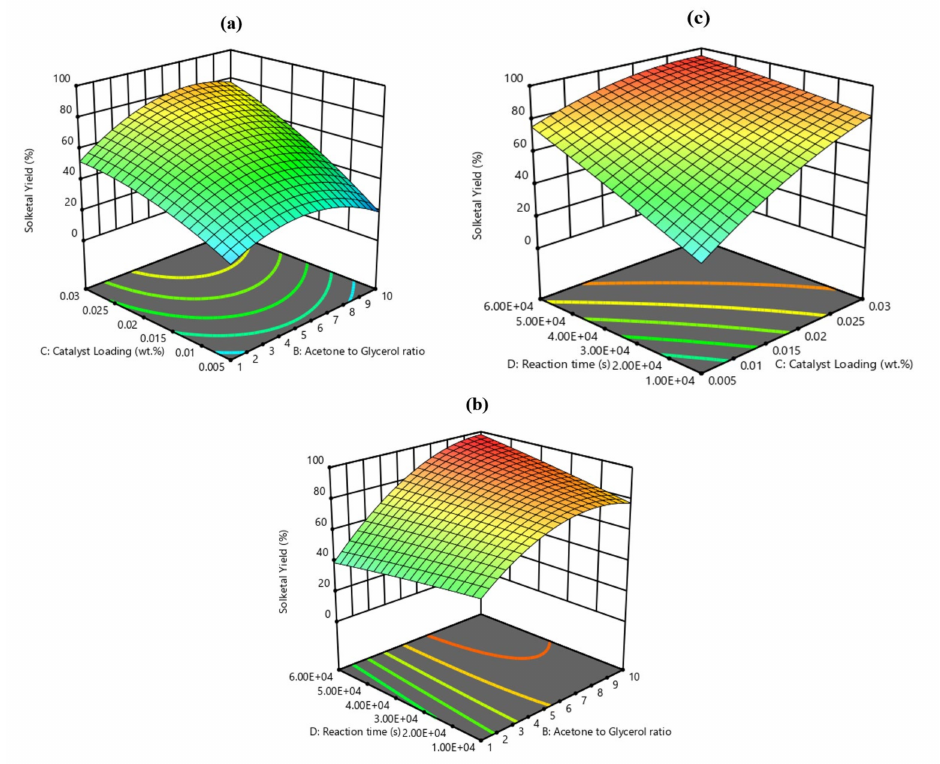
Figure 11. Surface plots of solketal yield for the interaction ( a ) catalyst loading vs. Acetone to glycerol molar ratio ( b ) catalyst loading vs. reaction time ( c ) reaction time vs. acetone to glycerol molar